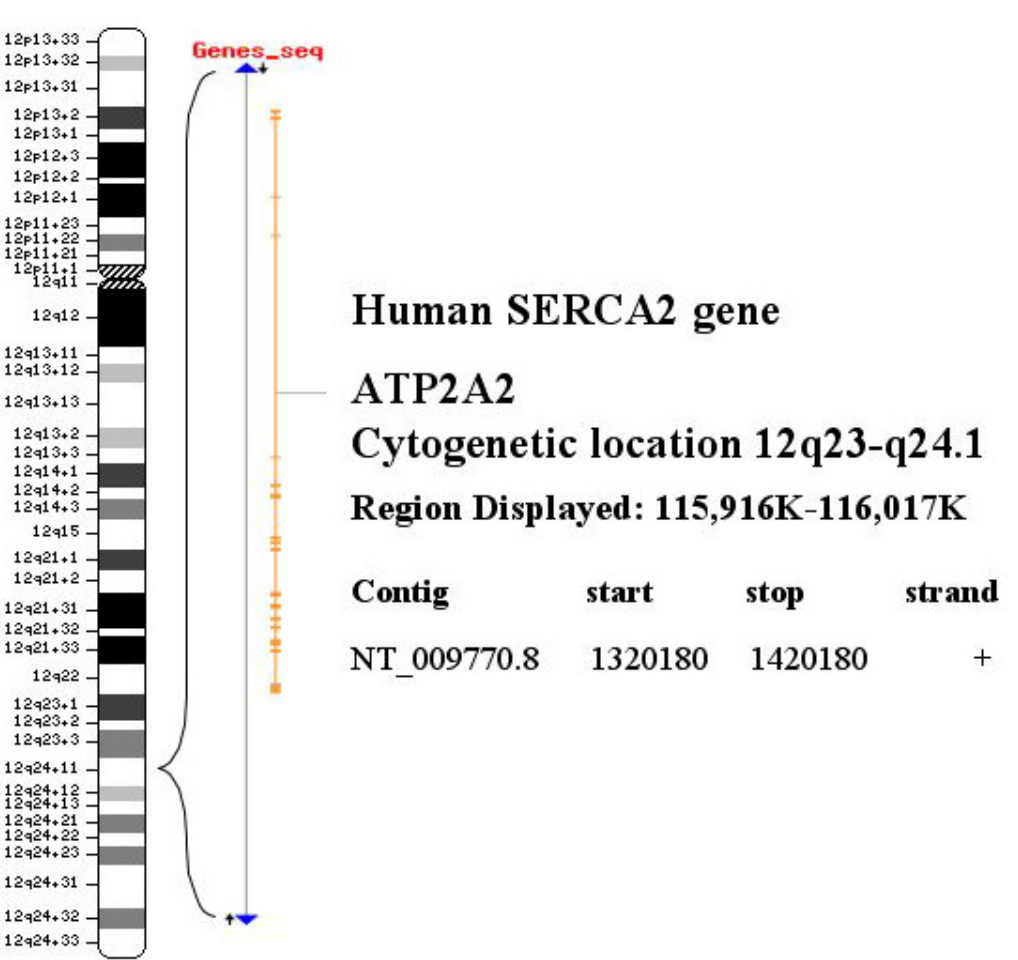
FIGURE 1. Chromosomal localization of the human SERCA 2 gene. The ideogram shows the localization of the SERCA2 gene in human chromosome 12. The schematic representation of exons of the SERCA2 gene in the 1320 to 1420 region of Contig NT_009770.8 in strand + is shown in